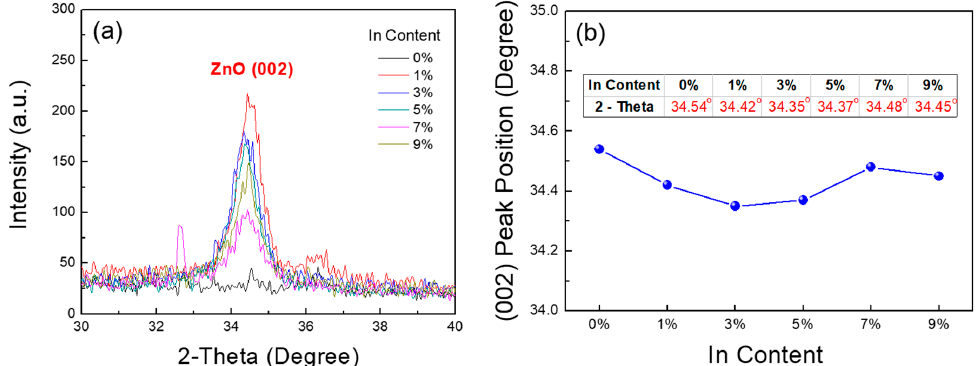
Figure 4. ( a ) XRD patterns and ( b ) the (002) peak positions of the fabricated films with different In contents.